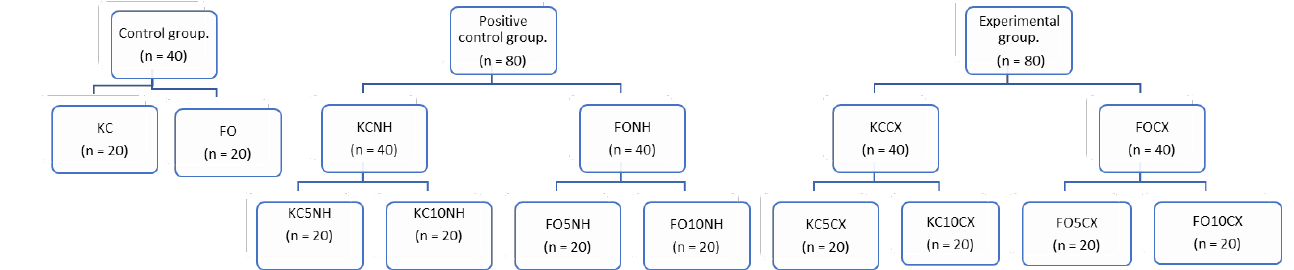
Figure 1. Sample distribution diagram for evaluation of antibacterial effect.